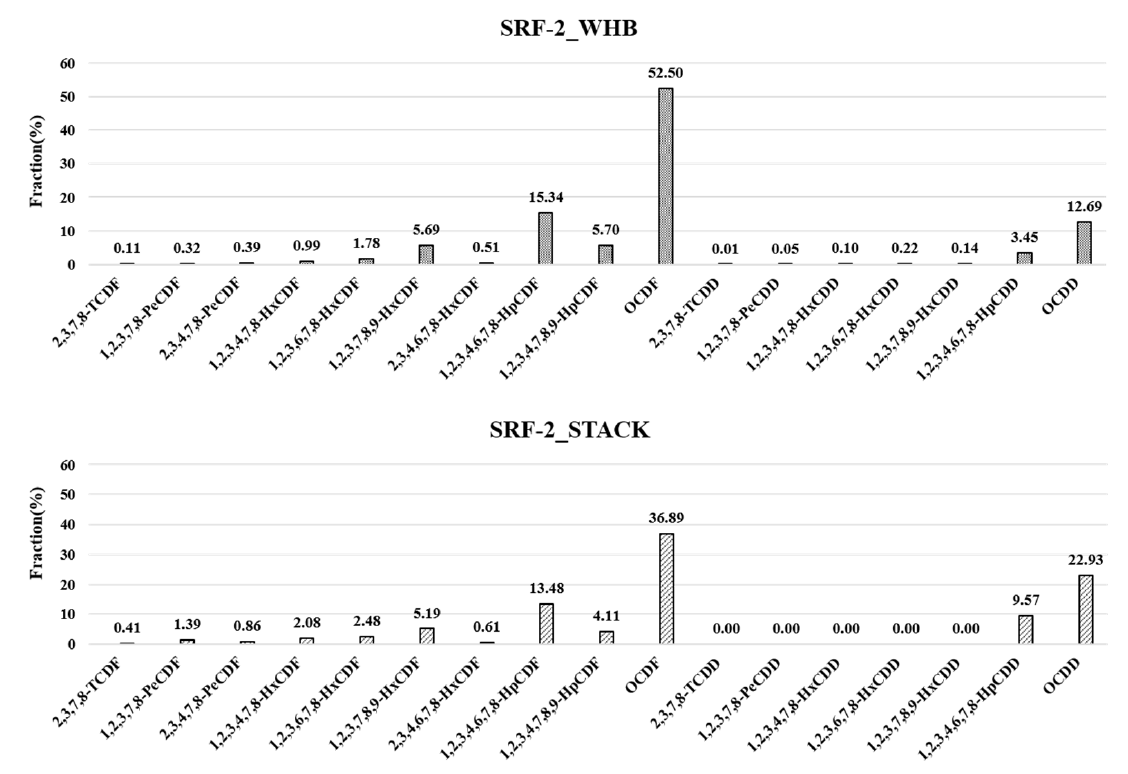
Figure 7. PCDD/DFs congener pattern in an SRF-2 incineration plant.